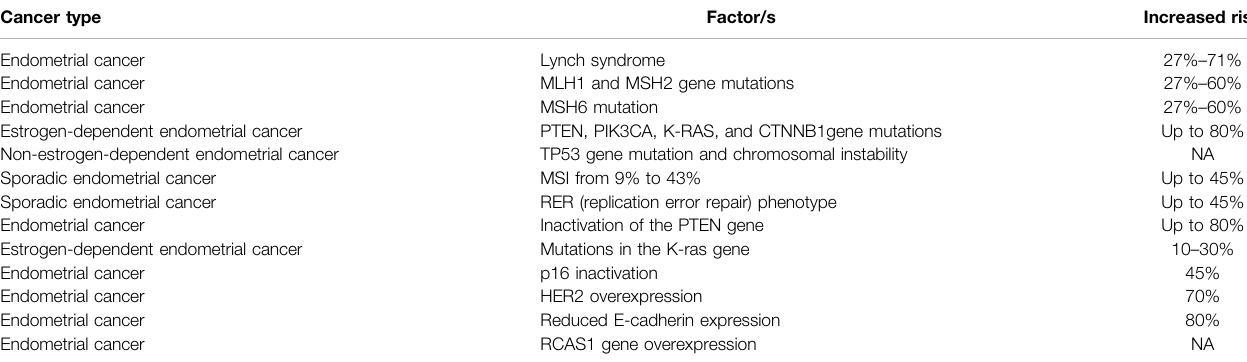
TABLE. 3 | Some factors involved in endometrial malignancies. Cancer type